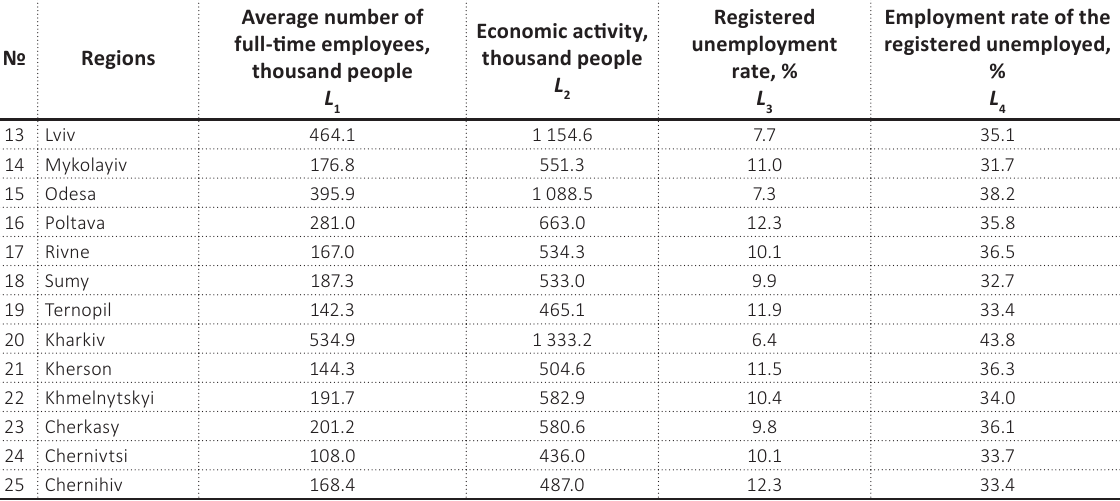
Table C3. Indicators of provision of Ukraine’s regions with production resources in